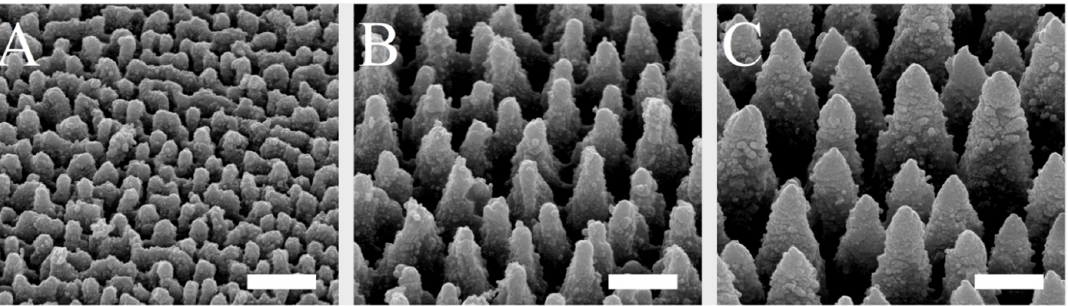
Figure 1. SEM images of small ( A ), medium ( B ), and large spikes ( C ). These spike structures were produced on silicon plates by laser ablation and then coated with titanium. Scale = 5 µm.